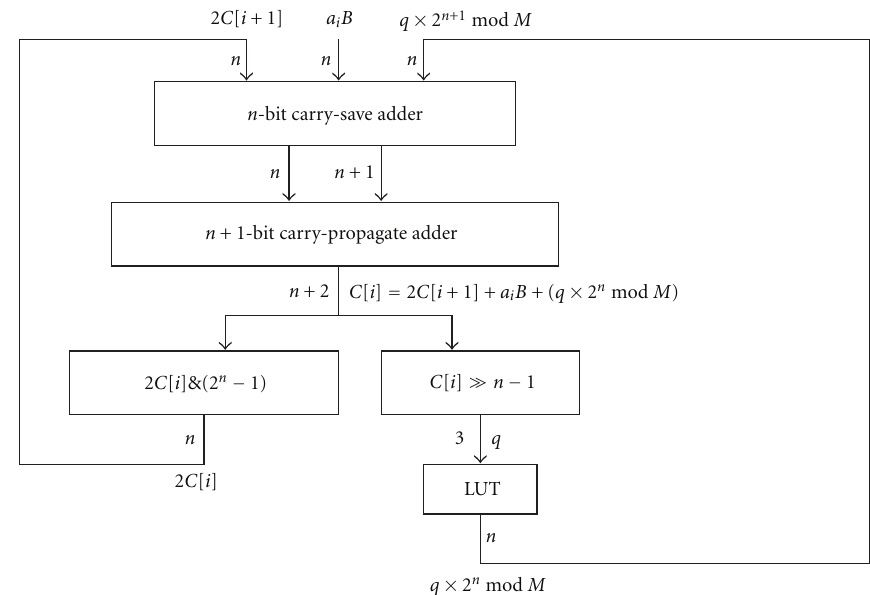
Figure 1: An architecture for Tomlinson’s interleaved modular multiplication algorithm.